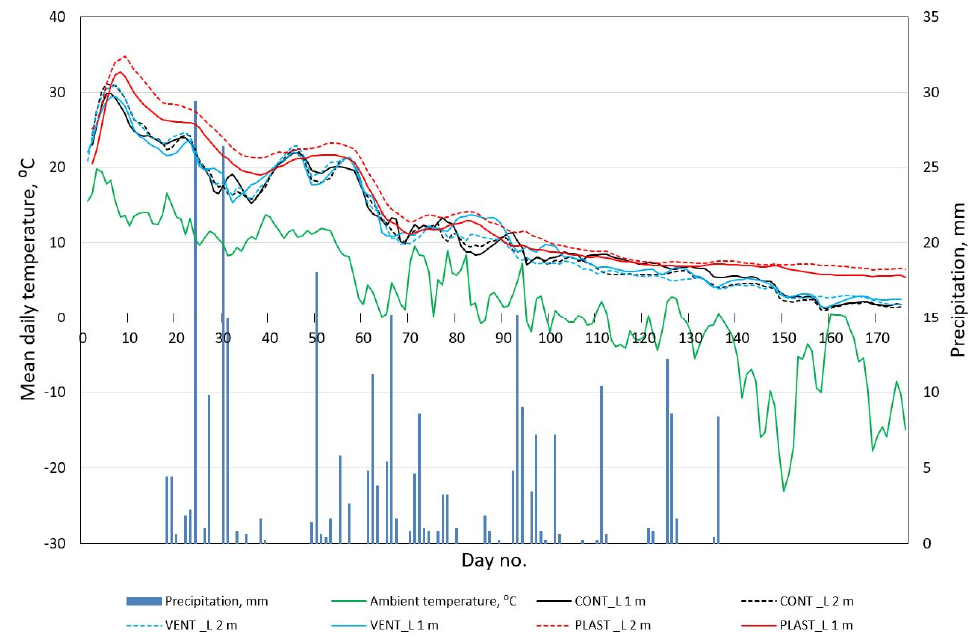
Figure 5. The mean daily ambient and internal temperatures for uncovered control (CONT), venti- lated (VENT), and plastic-covered piles (PLAST) at 1 m and 2 m levels. Precipitation was recorded by the portable weather station installed at the experimental area. The rain gauge used could not measure potential precipitation at temperatures below 0 °C.